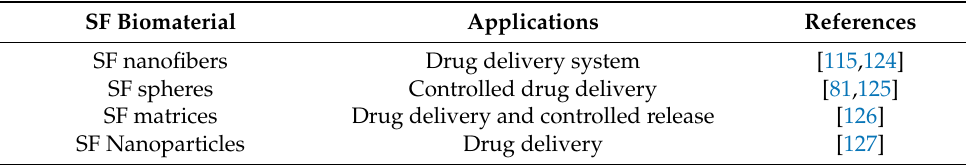
Table 4. Various functionalized SF for controlled or redirected